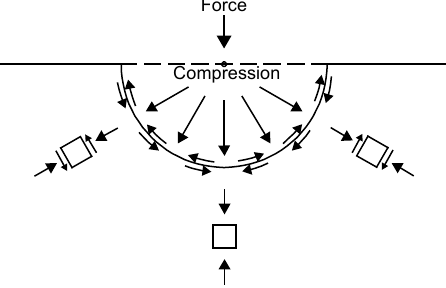
Appl. Sci. 2020 , 10 , x FOR PEER REVIEW